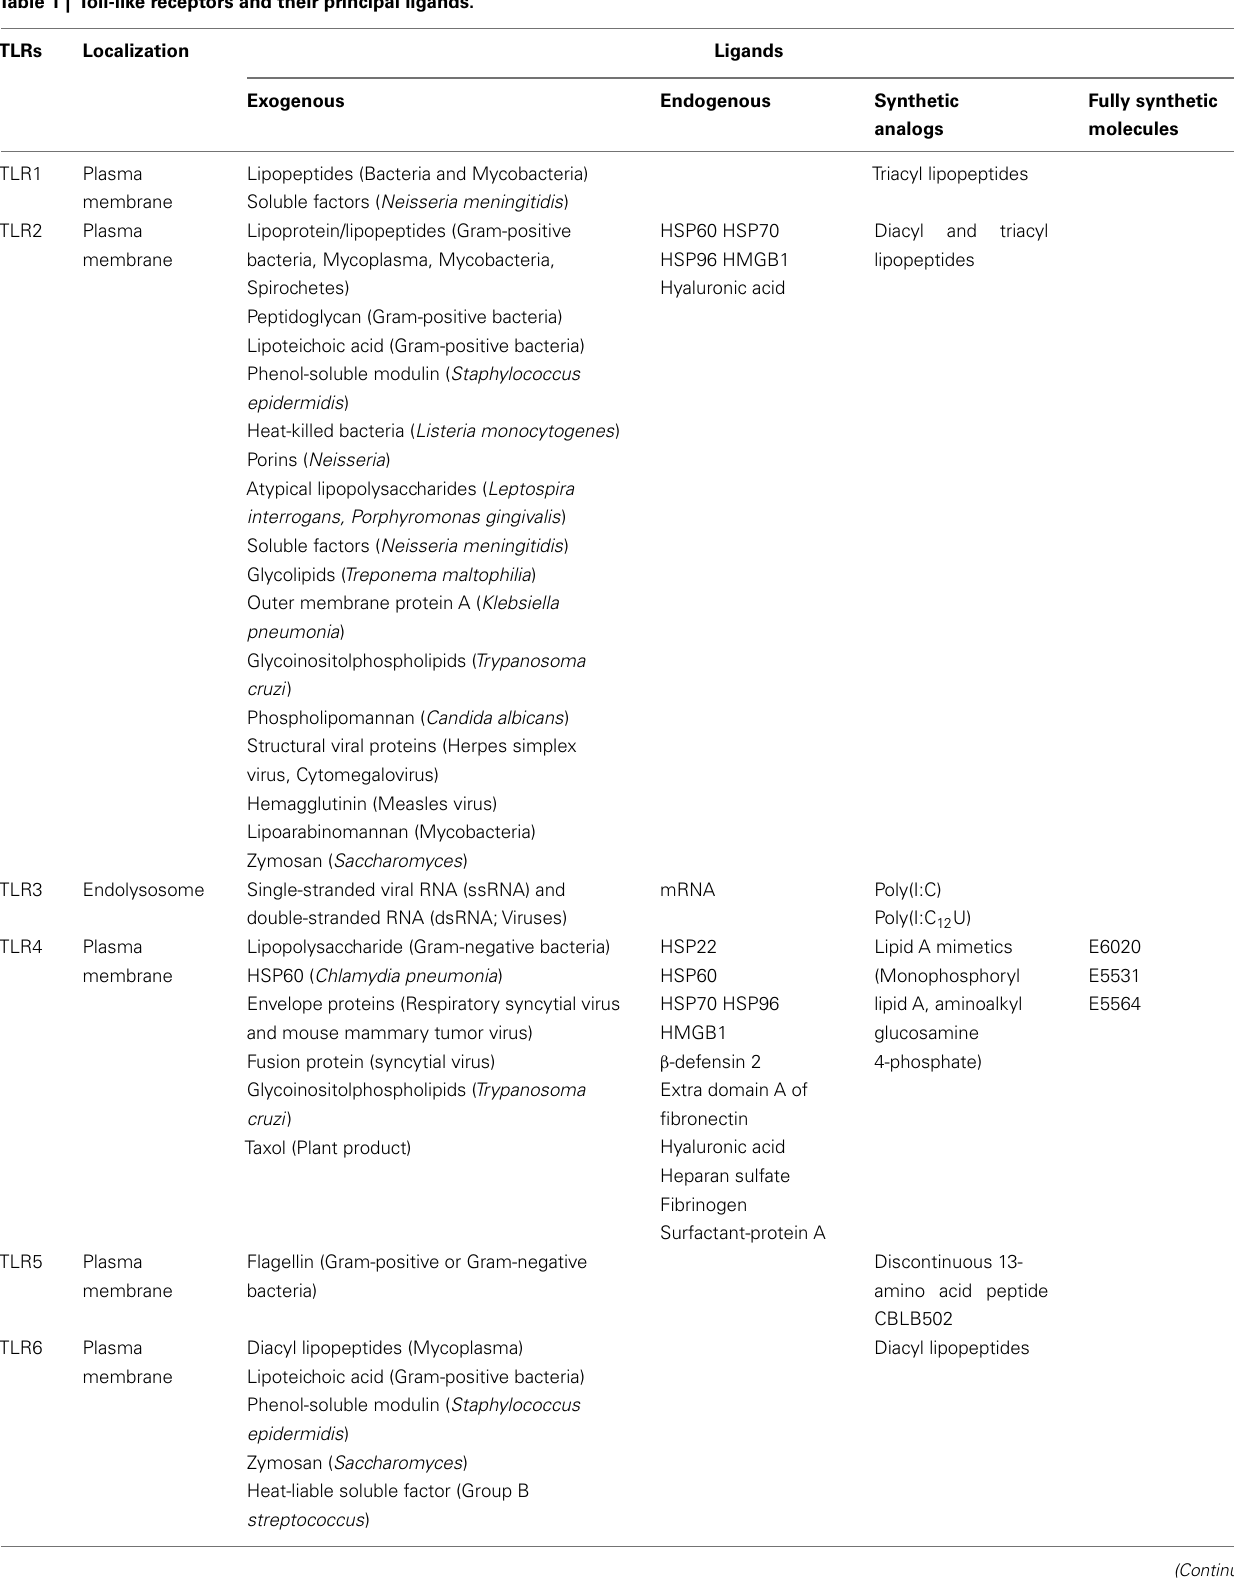
Table 1 | Toll-like receptors and their principal ligands. TLRs